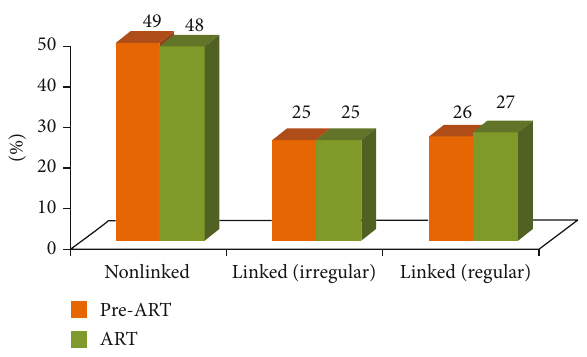
Figure 1: The percentage of children in pre-ART and ART groups, by type of ART center in